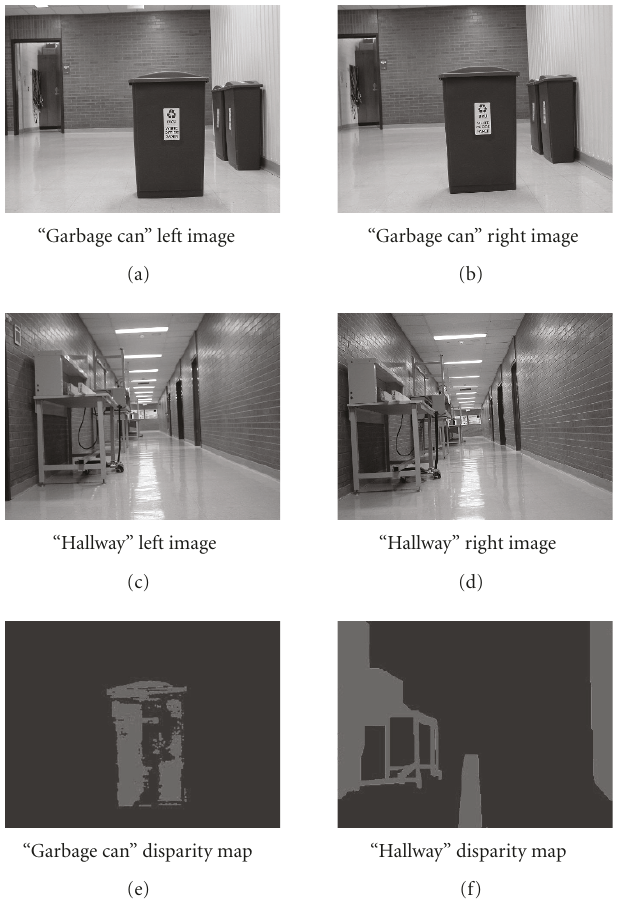
Figure 9: Indoor scenes: “garbage can” and